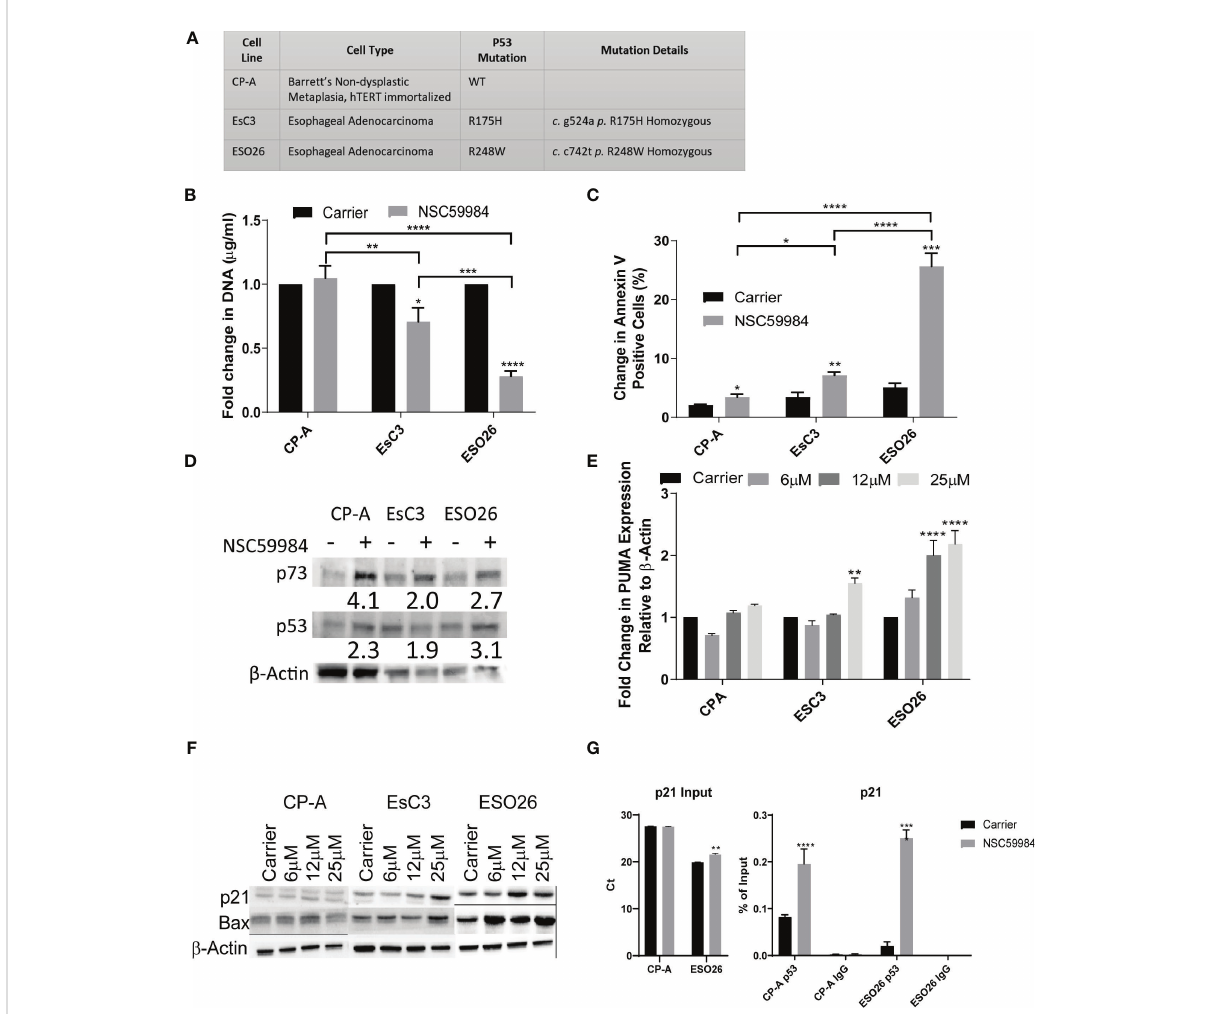
FIGURE 1 NSC59984 treatment re-activates WT-p53 signaling and intrinsic apoptosis. (A) Panel of EAC cells studied, providing their biological origin and associated TP53 status. (B) Cellular proliferation was determined by fold change in CyQUANT measurement of cellular DNA following treatment with NSC59984 (12 m M) for 72 hr over carrier control in EAC cells. Fold change in carrier-treated cells was normalized to 1. A 2-way ANOVA test with Tukey correction was carried out for statistical analysis. (C) Analysis of apoptosis in EAC cells as measured by change in percentage